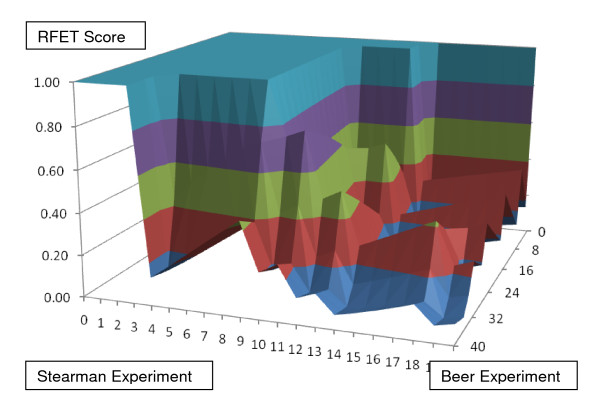
BLANKET applied to comparison of lung cancer microarray studies of Beer and Stearman. The method fails to find a threshold pair with low RFET score < .00800, which would be sufficient for shortlists with up to 20 members to have statistical significance in a universe of 489 descriptors. This surface is more organized than random BLANKETs, since there is a sharp decrease from 1 to low values, but it is less organized than those in Figures 3 and 4.